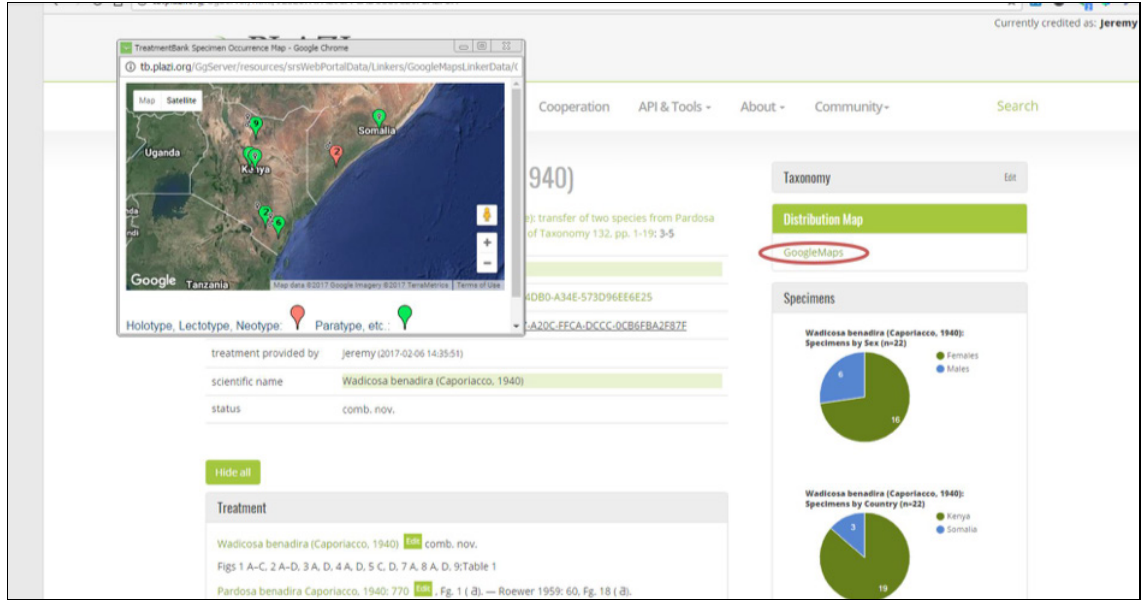
Fig. 3. A taxonomic treatment extracted from the European Journal of Taxonomy and displayed on the Plazi Treatment Bank. In the right-hand sidebar, the parsing performed on the specimen citations has been used to generate graphic charts of the material studied. In the inset, a map has been generated via GoogleMaps by plotting the extracted